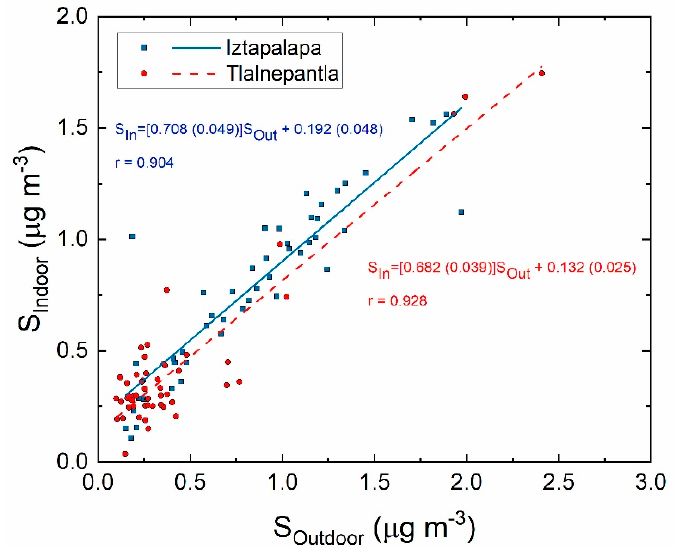
Figure 6. Sulfur concentrations measured indoors as a function of the sulfur concentrations measured outdoors. The numbers between parentheses represent the uncertainty of the fitted parame- ters.